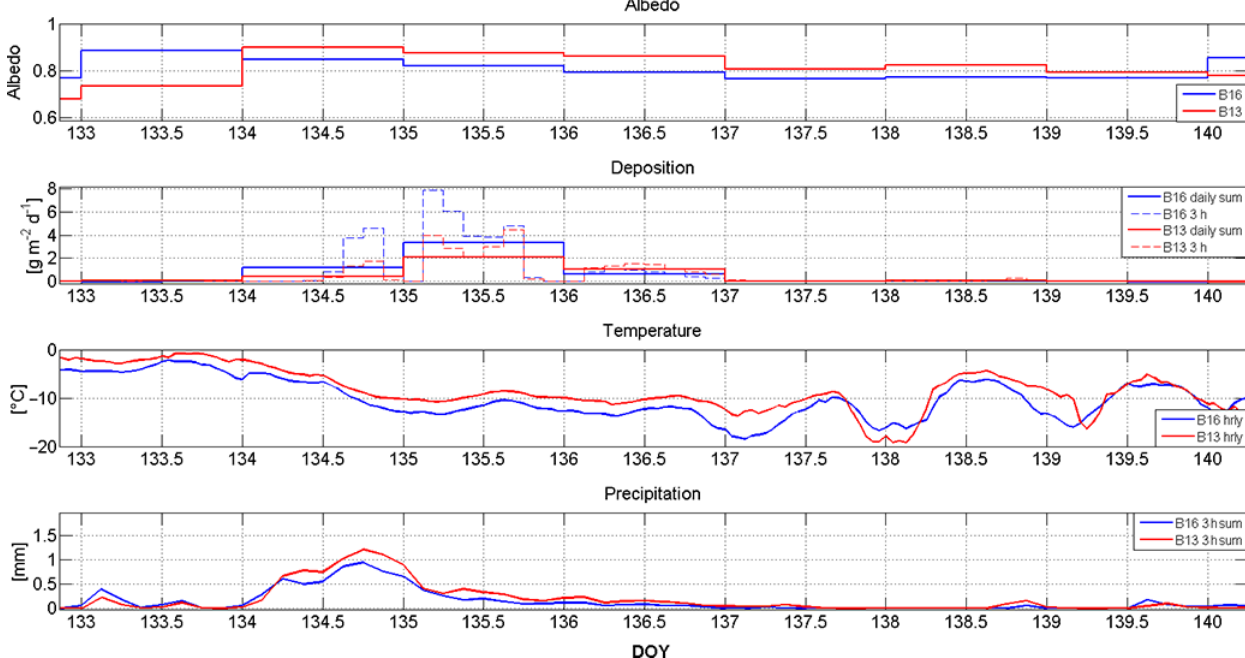
Figure 4. Observed albedo, simulated dust deposition, observed temperature and simulated precipitation dust event no. 1 at stations B16 (blue) and B13 (red). Modelled deposition is shown for 3h and daily averages.